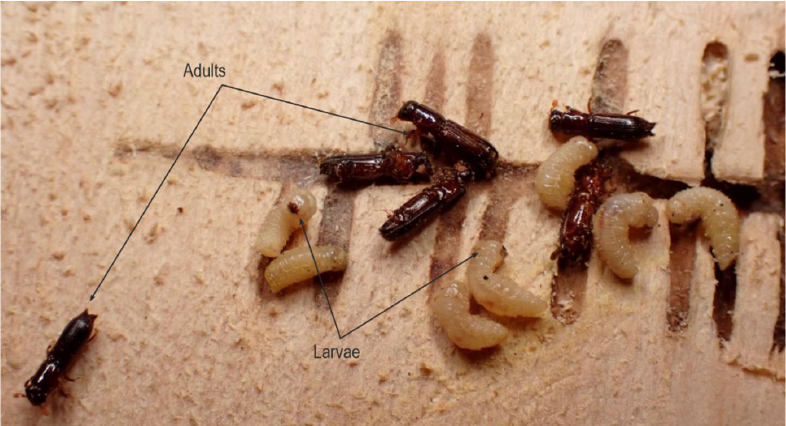
Figure 8. Gallery system with larvae and young adults of T. oxyurus.